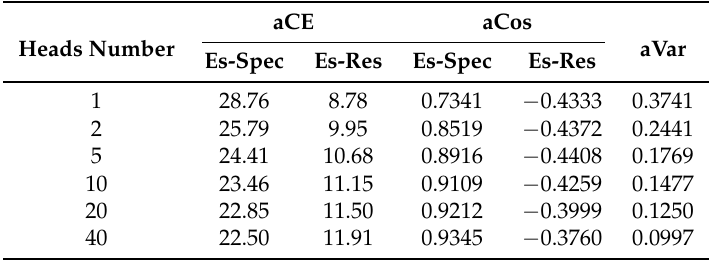
Table 2. Statistic about the estimated spectrogram and estimated residual of different heads number. “Es-Spec” and “Es-Res” stands for estimated spectrogram and estimated residual